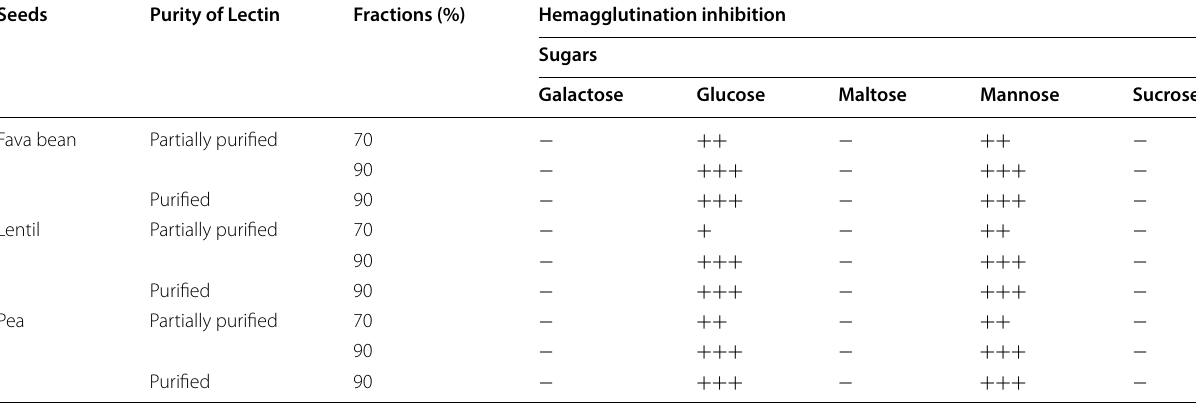
The number of signs indicate the amplitude of relative hemagglutination inhibition + positive hemagglutination inhibition;